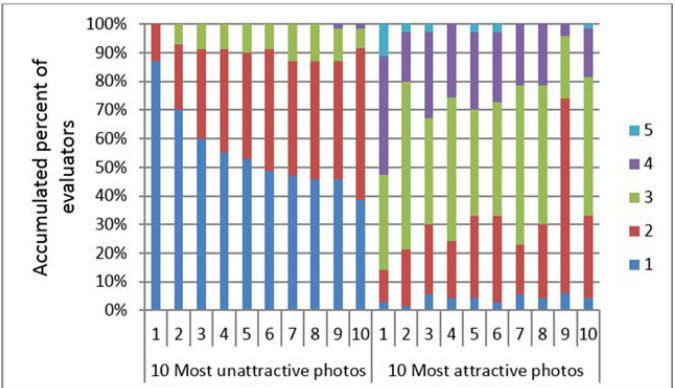
Figure 5. Comparison between accumulated percent of evaluators evaluated the 10 most unattractive and 10 most attractive 3D contour lines at the first time. Evaluators evaluated the 10 most unattractive faces (within 4 scales) more consistency than evaluated the 10 most attractive faces (within 5 scales).